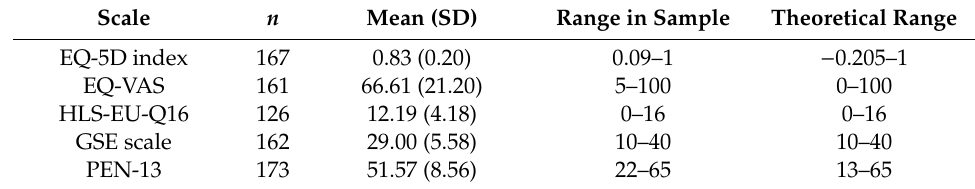
Table 2. Description of the scores for health-related quality of life (EQ-5D index), health status